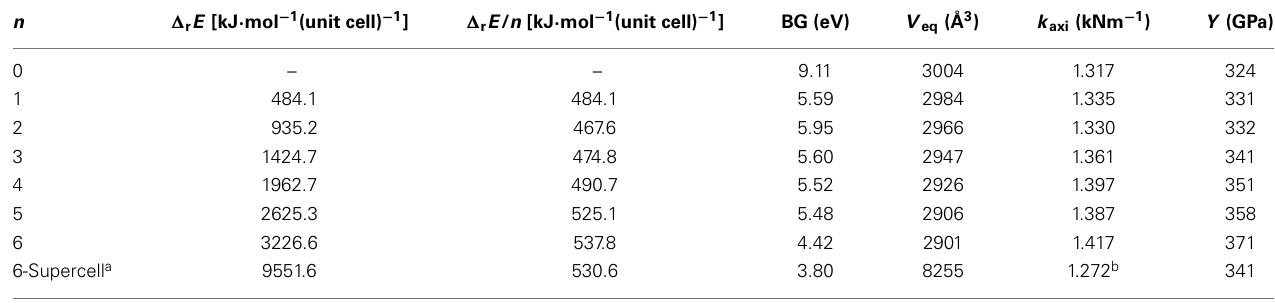
Table 3 | Reaction energy of the dehydroxylation of imogolite in the same radial line